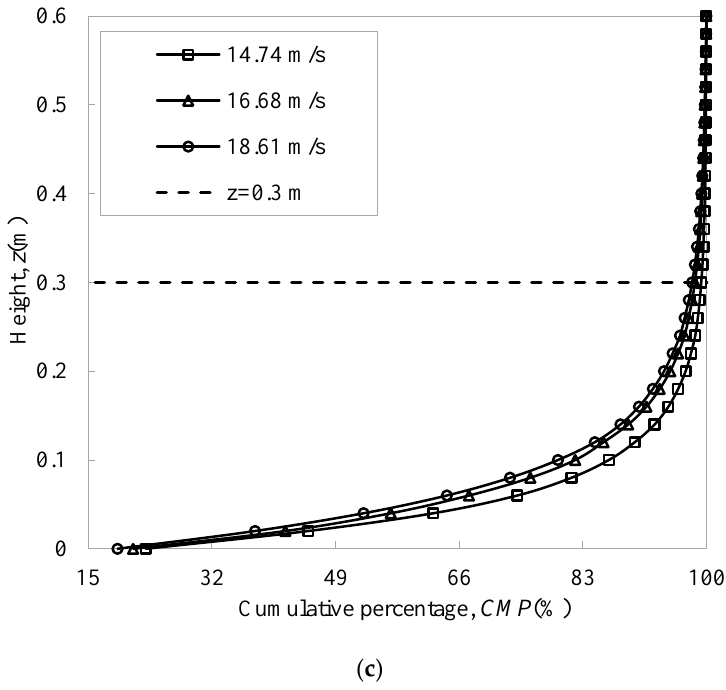
Figure 7. Cumulative mass percentage: ( a ) Coarse sand; ( b ) Fine sand; ( c ) Mixed sand.